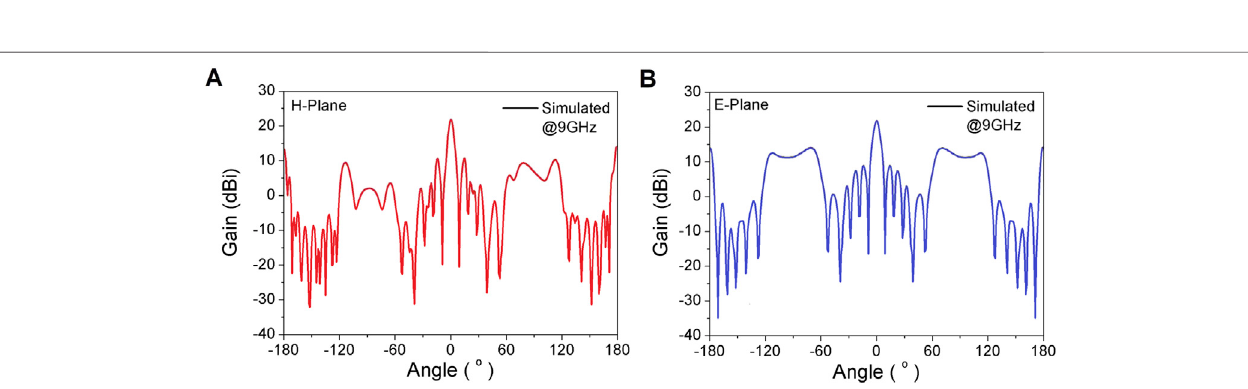
Frontiers in Materials |